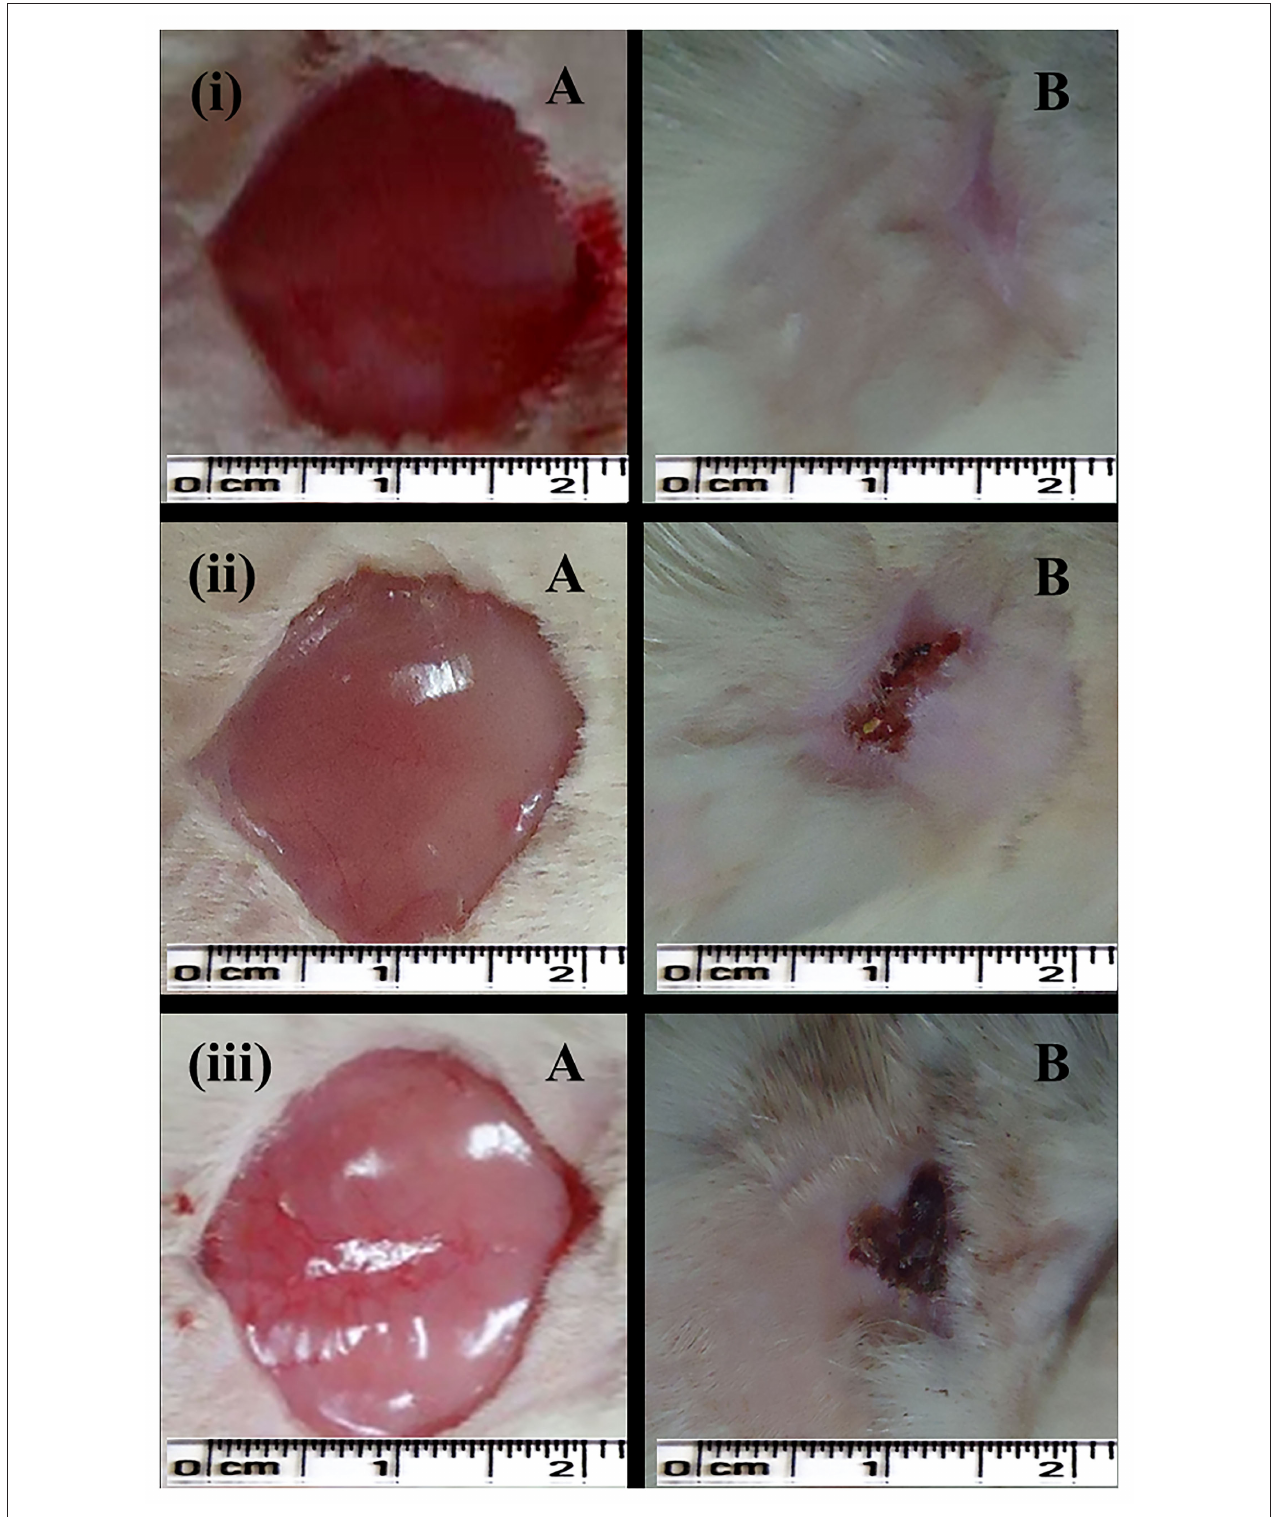
FIGURE 4 | Excision wound-healing model (albino Wistar) for formulated silver nanogel, marketed drug, and untreated (control) group. (i) Excision wound treated with silver nanogel at a concentration of 0.1mg g − 1 (Group A); (ii) Excision wound treated with marketed drug silverex 0.2% (Group D); (iii) Untreated (control) group (Group F), where (A) Excision wound created on the first day and (B) Excision wound completely healed on 20th day after treatment.